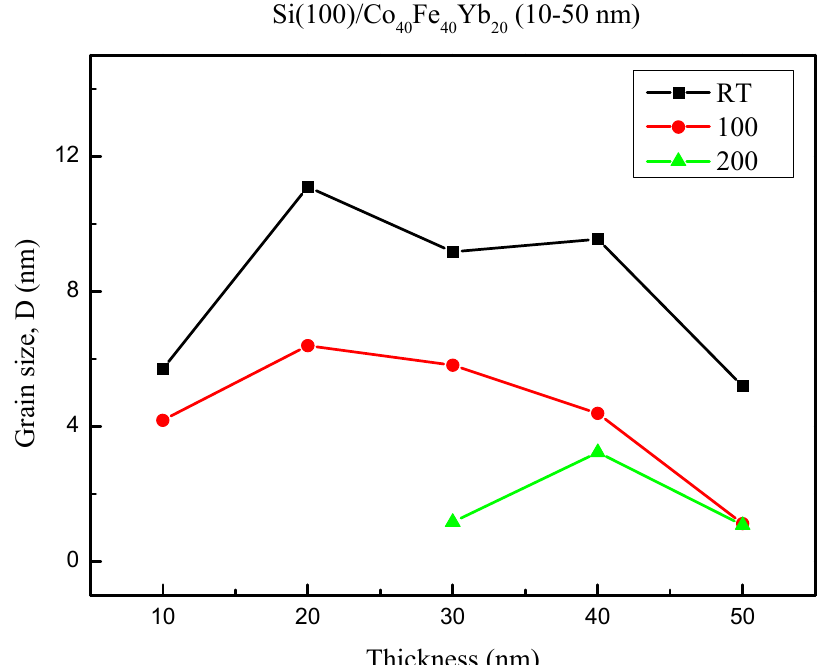
Figure 1. Thin films made of Co 40 Fe 40 Yb 20 with X-ray diffraction patterns. ( a ) As-deposited, ( b ) post-annealing at 100 °C, ( c ) post-annealing at 200 °C, and ( d ) post-annealing at 300 °C.